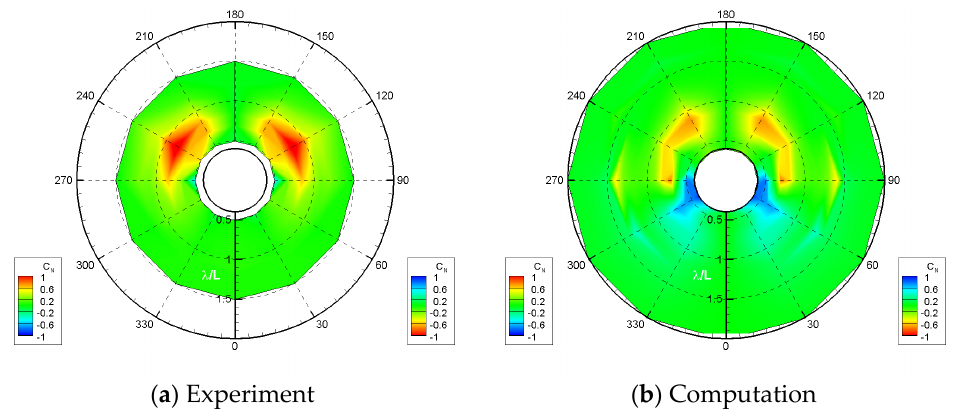
Figure 17. Polar diagram of yaw wave drift moment: KVLCC2, V = 6 knots.